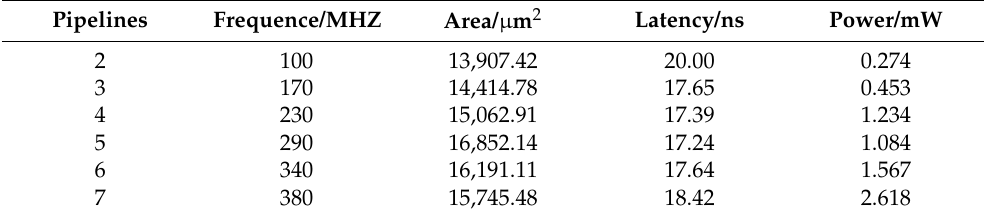
Table 4. Performance, power and area of a hardware circuit which supports all transcendental